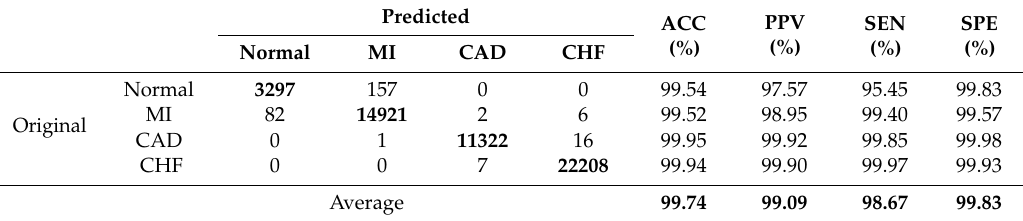
Table 9. The overall classification results for cardiovascular detection across 10-fold.